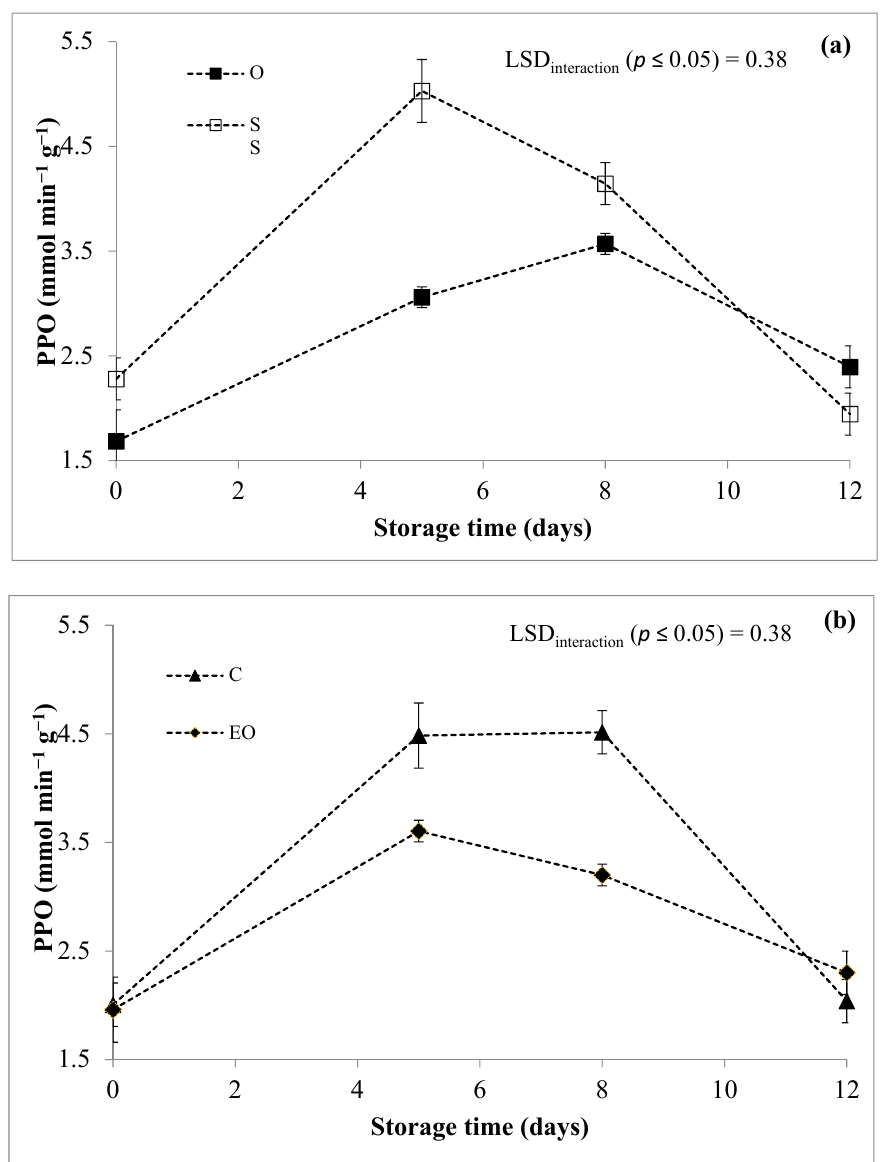
Figure 7. PPO activity of RTC globe artichoke slices as affected by “genotype × storage time” ( a ) and “treatment × storage time” ( b ) interaction. PPO: Polyphenol oxidase; O: “Opera F1”; SS: “Spinoso sardo”.C: Control; EO: Samples packed with essential oil of F. vulgare. Data are presented as means ± standard deviation.